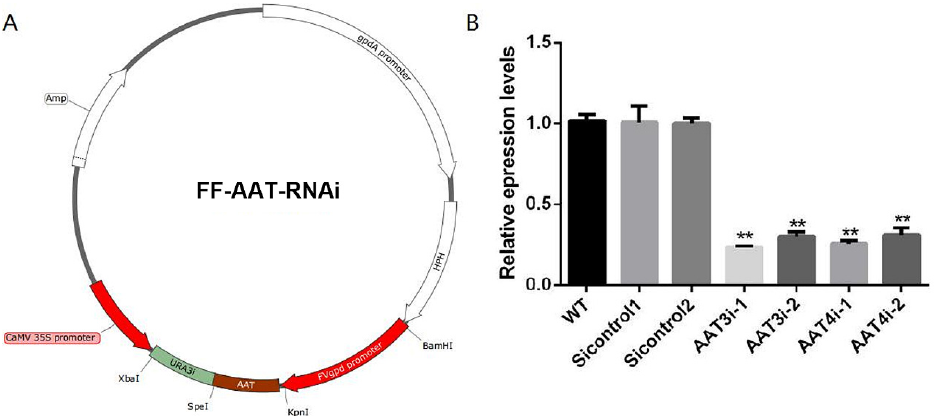
Figure 6. Construction and screening of AAT3-silenced and AAT4-silenced strains. ( A ) Construc- tion of the AAT3 and AAT4 RNAi expression cassette plasmids. The AAT3 and AAT4 fragments were double-digested with the restriction enzymes KpnI and SpeI, then inserted into the pAN7-dual plasmid. In the plasmid, URA3 transcription is driven by the 35S promoter, and the AAT gene is driven by the glyceraldehyde-3-phosphate dehydrogenase promoter. ( B ) QRT-PCR analysis of the expression of AAT in the tested strains. The expression levels of the AAT3 and AAT4 genes in the WT strains were arbitrarily set to 1. The values are the mean ± standard deviations (SD) of the results of three independent experiments. The asterisks indicate significant differences compared with the untreated strains (Student’s t -test: ** p